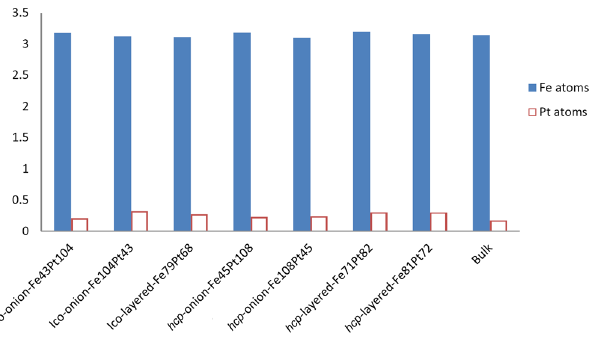
Figure 4. Mean magnetic moments of Fe and Pt atoms for some studied FePt NPs in μ B (from left to right): icosahedron “onion-like”